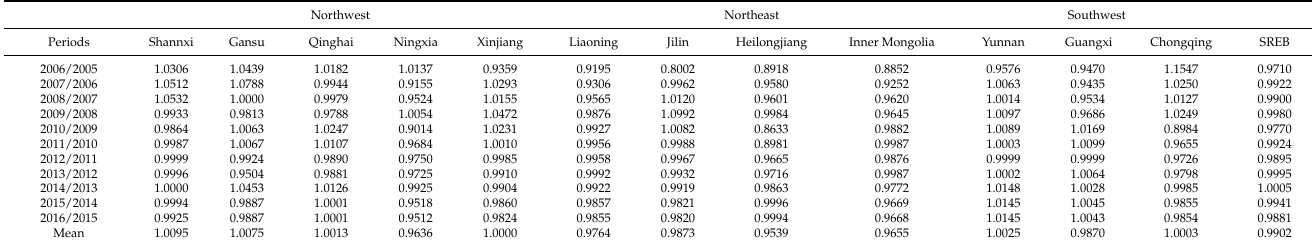
Table 5. Technical-progress performance by provinces along the SREB.